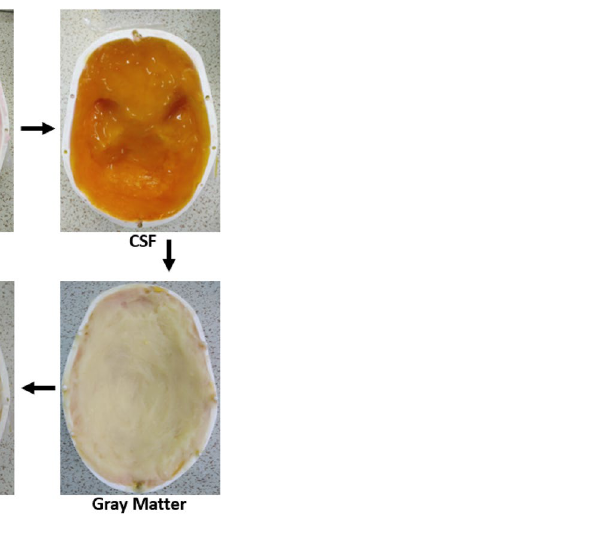
Figure 8. Overall placement process of the phantom